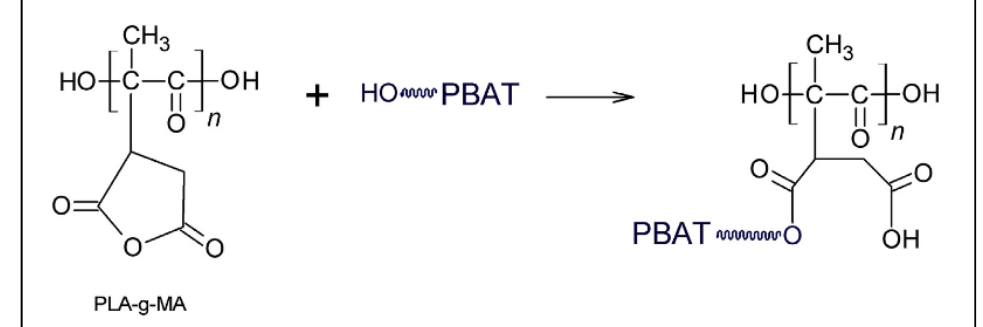
Figure 11. Possible reaction between PLA- g -MA and PBAT (from Rigolin et al. [50], copyright Else- vier, reproduced with permission).